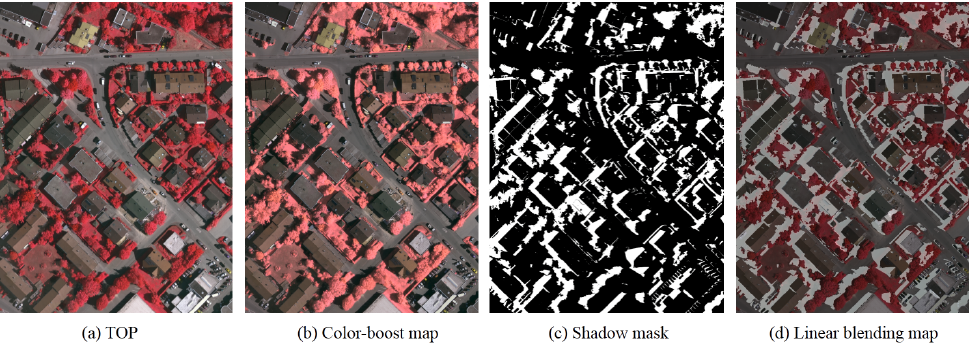
Figure 10. The example of labeled shadow mask (area 30). ( a ) TOP; ( b ) color-boost map by contrast preserving decolorization [61]; ( c ) manually labeled shadow mask, white pixels denote the shadow; ( d ) linear blending map of ( a ) and ( c ).